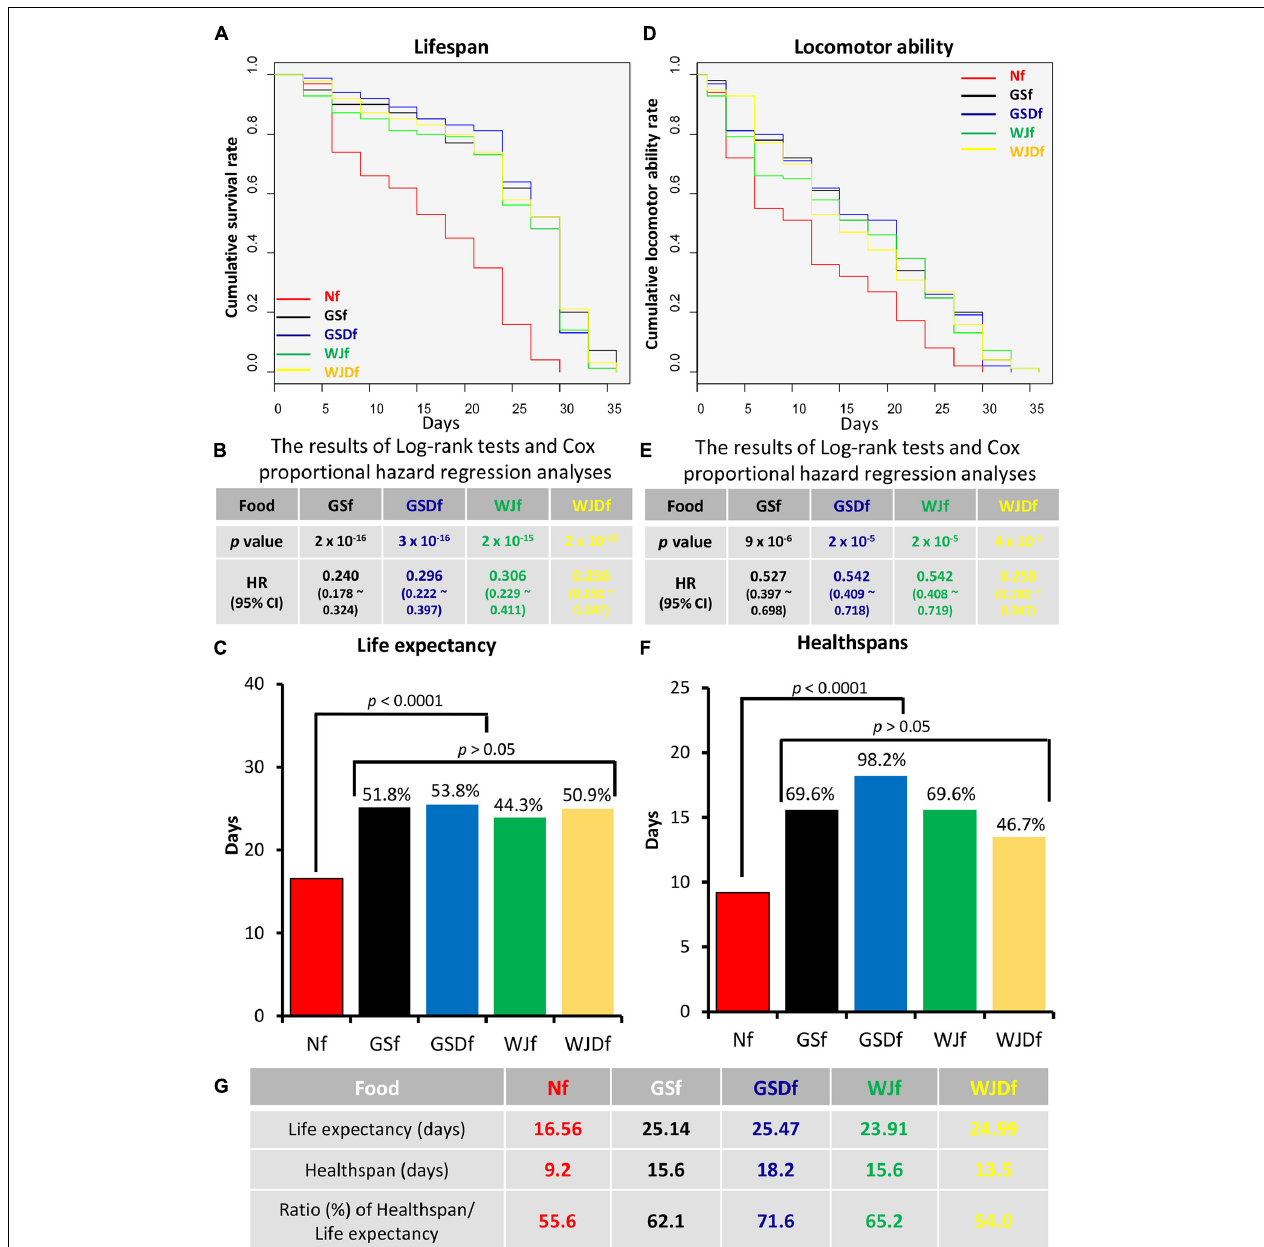
FIGURE 1 | The life expectancy and healthspan of Drosophila reared with various feeds. (A) The lifespans of Drosophila reared with GS feed (GSf), GSD feed (GSDf), WJ feed (WJf), or WJD feed (WJDf) were extended compared with that of Normal feed (Nf)-reared Drosophila. (B) When the life expectancy of Drosophila reared with GSf, GSDf, WJf, or WJDf was compared with that of Nf-reared Drosophila , the hazard ratios (HRs) were significantly reduced ( p < 0.005). (C) Compared to Nf-reared Drosophila , the average lifespans of GSf-, GSDf-, WJf-, or WJDf-reared Drosophila were increased. (D) Compared with Nf-reared Drosophila , the voluntary locomotor abilities of GSf-, GSDf-, WJf-, or WJDf-reared Drosophila were significantly increased. The period of Drosophila retained voluntary locomotor ability was defined as the healthspan. (E) The HRs of GSf-, GSDf-, WJf-, and WJDf-reared Drosophila were significantly reduced ( p < 0.005). (F) The healthspans of GSf-, GSDf-, WJf-, or WJDf-reared Drosophila were significantly increased. (G) The ratios of life expectancies and healthspans were higher in GSDf-, GSf-, and WJf- but lower in WJDf-reared Drosophila than in Nf-reared Drosophila .